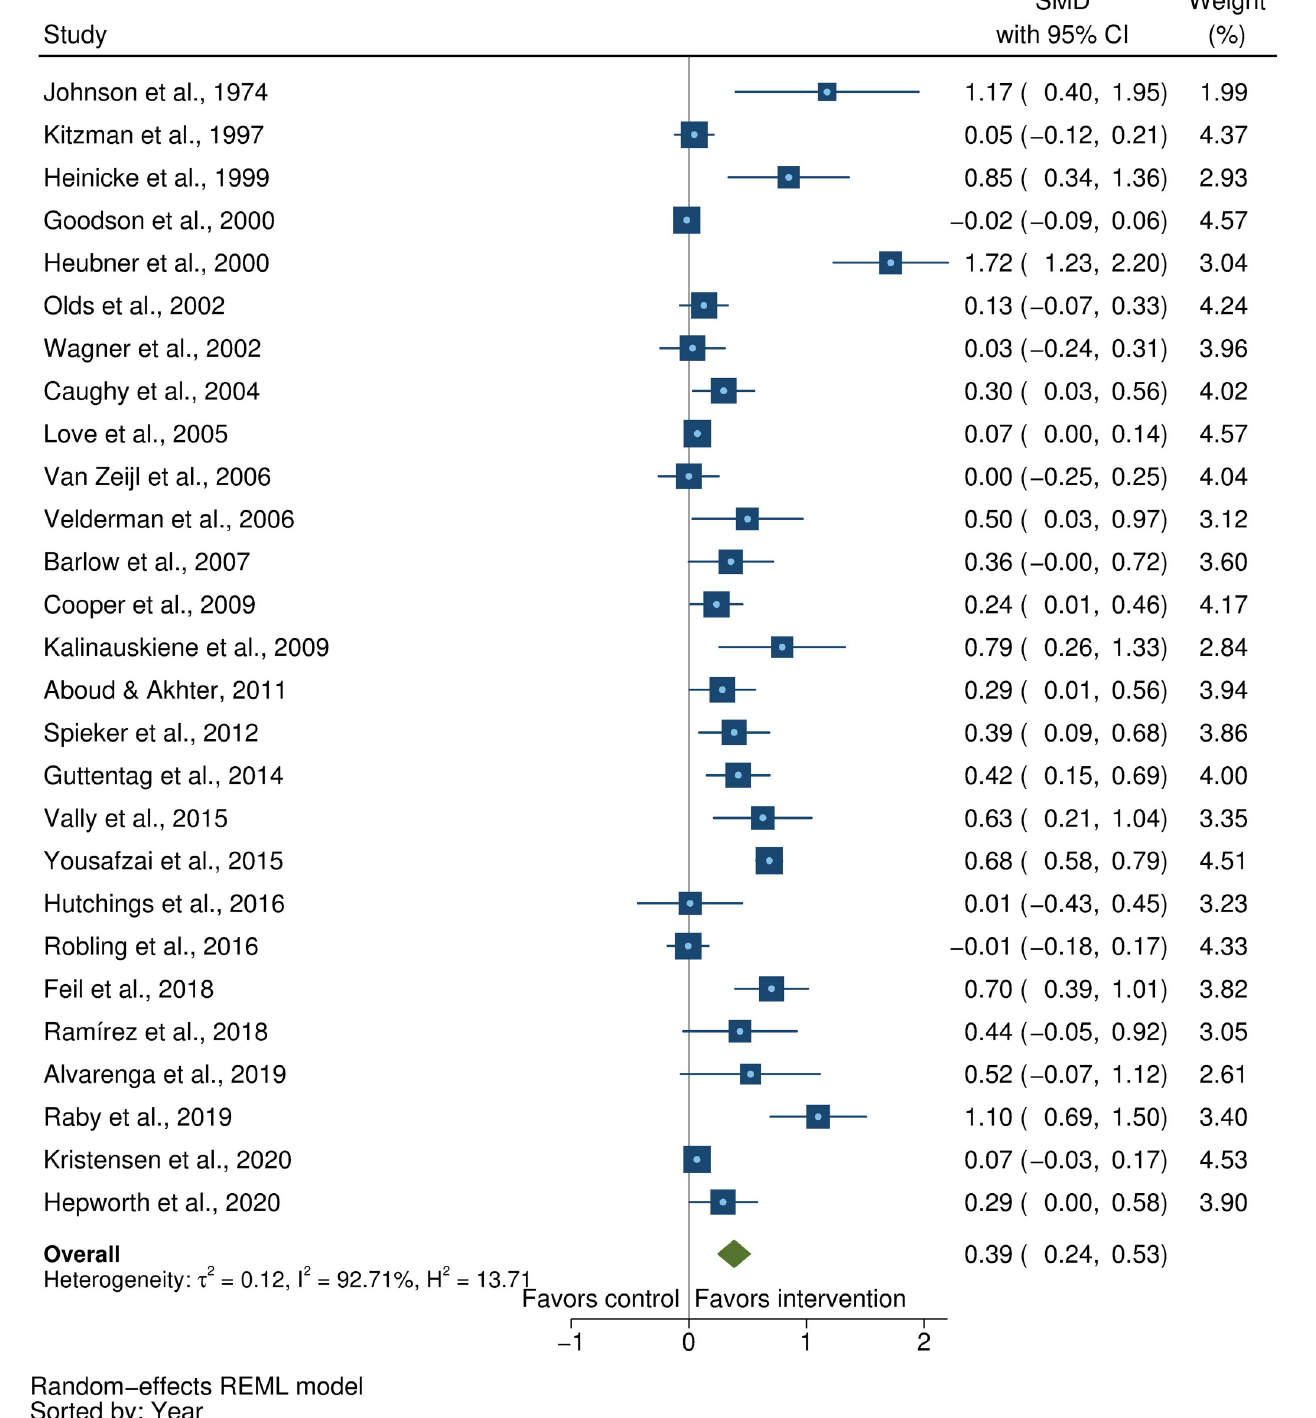
Fig 10. Forest plot for the effect of parenting interventions on parent–child interactions. Blue squares represent the SMD for each study, with the size of the square being proportional to the study weight. The whiskers extending from each side of the square represent the range of the 95% CI. The green diamond shows the overall pooled effect size using a random-effects model, which is centered at the point estimate and the diamond width representing the 95% CI. SMD, standardized mean difference.